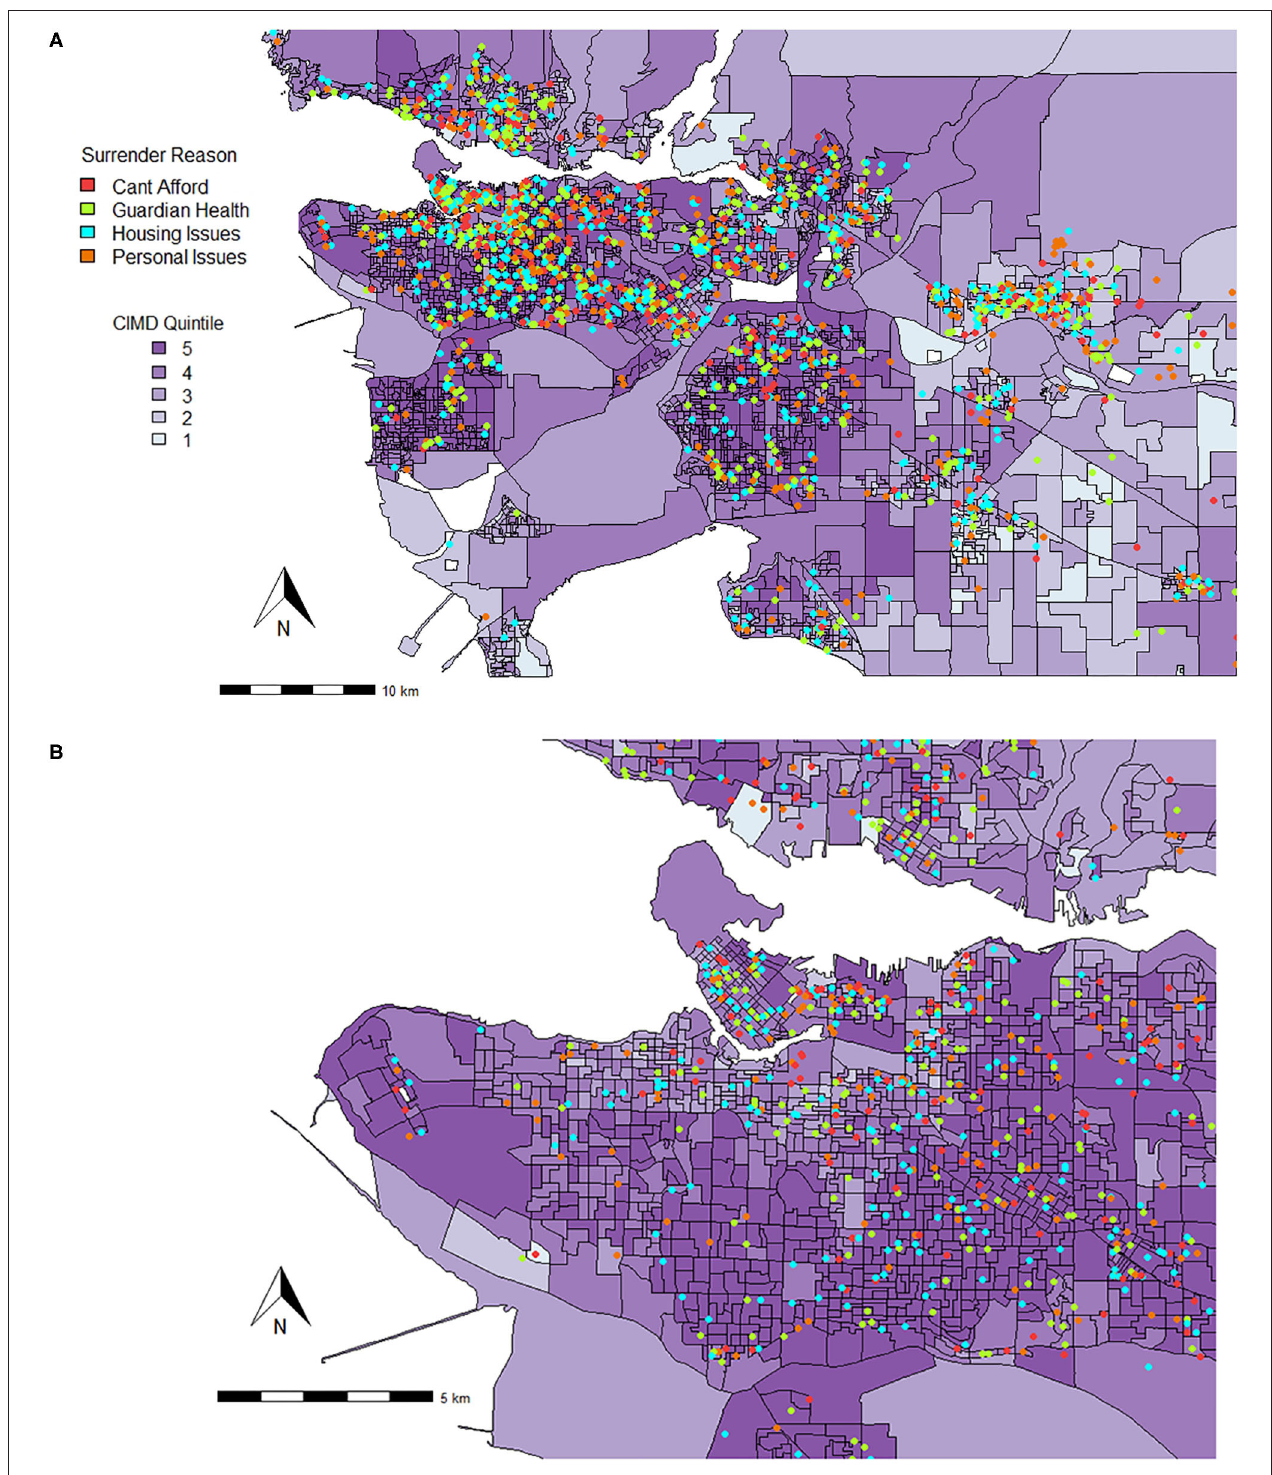
FIGURE 3 | Locations where animals were surrendered for various owner-related reasons for surrender in (A) Metro Vancouver and (B) the City of Vancouver (September 1, 2016 to August 31, 2020) plotted on top of quintiles for Ethnocultural Composition (1 = least composition, 5 = most composition). The Ethnocultural Composition factor of the CIMD includes indicators such as the proportion of self-identified visible minorities; the proportion of foreign-born population; proportion of recent immigrants; and proportion of linguistically isolated population (no knowledge of either official language). While each point shows the dissemination area of origin, it does not represent the true